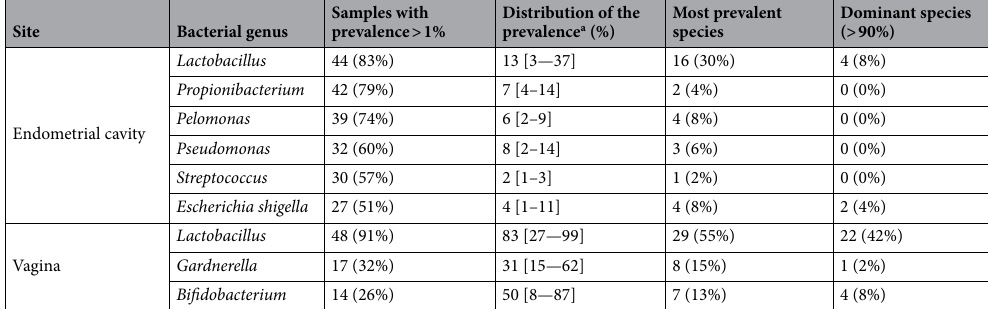
Sixteen women became pregnant (30%), ten (19%) had a live birth (these cases are highlighted in green in the Supplemental Tables). In the 16 pregnant women, the number of cases where Lactobacillus prevailed in the endometrial and vaginal samples was 5 (29%) and 9 (53%), respectively (p = 0.16). For live birth, these numbers were 3 (33%) and 4 (40%) (p = 0.64), respectively. Two of the 4 subjects classified as Lactobacillus dominant in endometrial sample became pregnant. Results of presence and distribution of bacterial species in the vaginal and endometrial samples in subjects who did and did not become pregnant are illustrated in Supplemental Figs. 1 and 2. No significant differences could be observed. Shannon index for endometrial samples between pregnant and not pregnant women was 3.11 [2.72–3.38] and 2.80 [2.40–2.95] (p = 0.036), respectively. Shannon’s Equitability index in pregnant and not pregnant women was 0.76 [0.57–0.87] and 0.55 [0.51–0.64] (p = 0.002), respectively (Fig. 2, upper panel) suggesting a higher biodiversity in association with pregnancy establishment.